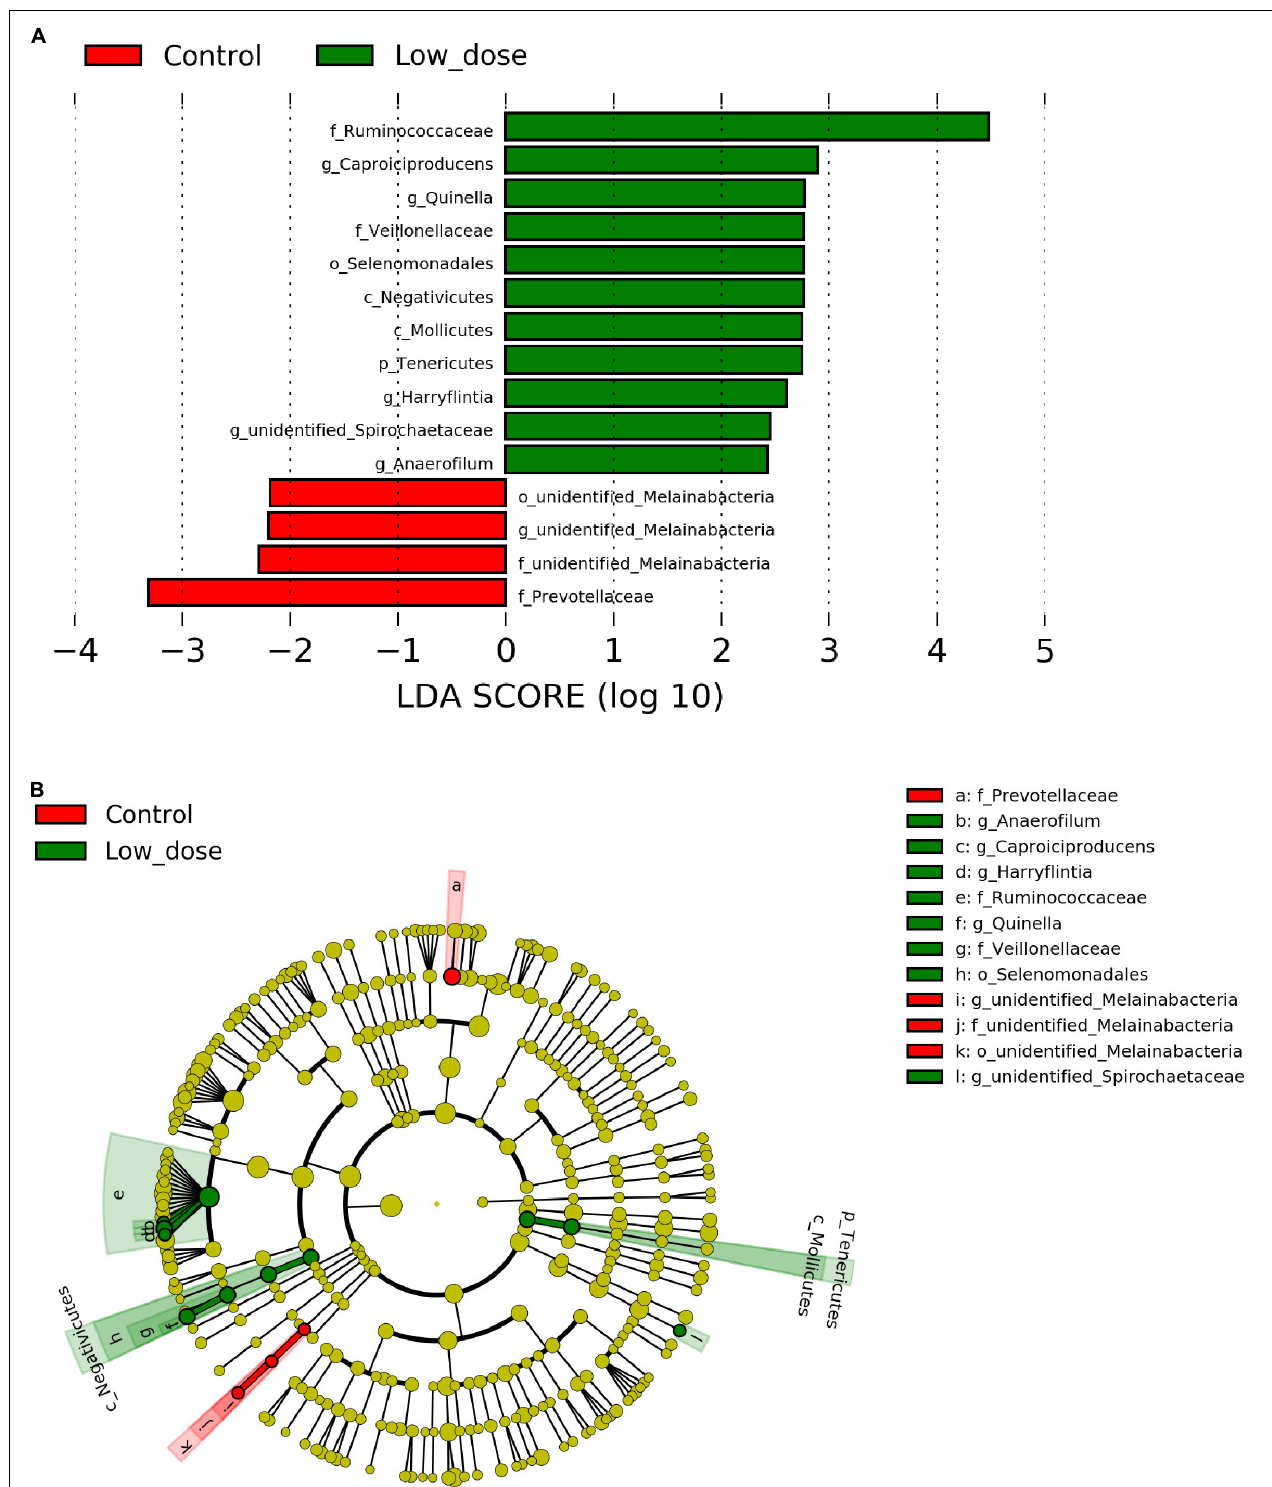
FIGURE 4 | Biomarker of taxa with statistically significant differences in abundance identified in the cecal microbiota among control group (0 mg/kg 6-MBOA), low 6-MBOA dose group (1 mg/kg 6-MBOA) and high 6-MBOA dose group (2 mg/kg 6-MBOA) in adult male Brandt’s vole by linear discriminant analysis (LDA) effect size (LEfSe) analysis ( n = 6). (A) Histogram showing the taxa with a LDA score significant threshold > 2. (B) Cladogram showing the phylogenetic position of enriched taxa among the three groups, according to the LEfSe analysis.